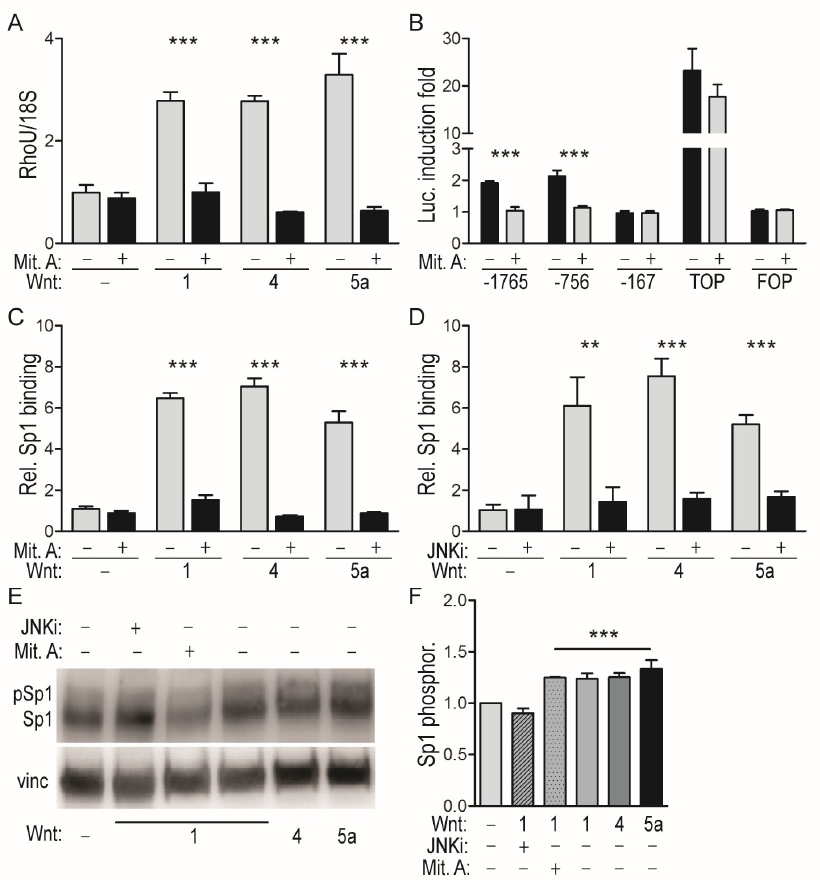
Figure 2. JNK-mediated SP1 recruitment is responsible for RhoU promoter induction by WNT ligands. ( A ) RhoU mRNA levels measured by qRT-PCR in MEF cells stimulated for 24 h with the indicated WNT ligands as described in the legend to Figure 1, in the presence or absence of the SP1 inhibitor Mithramycin A (Mit. A). Mean ± SEM of the relative expression levels normalized to the 18S rRNA; n = 3. ( B ) The indicated RhoU promoter constructs were transfected in MEF cells as described in the legend to Figure 1C, followed by WNT1 stimulation in the presence or absence of Mit. A. Data are mean ± SEM of the luciferase induction fold, relative to unstimulated condition. n = 3. ( C , D ) SP1 binding to the RhoU promoter measured by ChIP assay in MEF cells stimulated for 24 h with the indicated WNTs, in the presence or absence of Mit. A ( C ) or of the JNK inhibitor JNKi ( D ). Immunoprecipitated chromatin was analyzed by qRT-PCR, and data (mean ± SEM) obtained upon normalization to total input (T.I.) and IgG. n = 3. ( E ) Western blot showing WNT-dependent